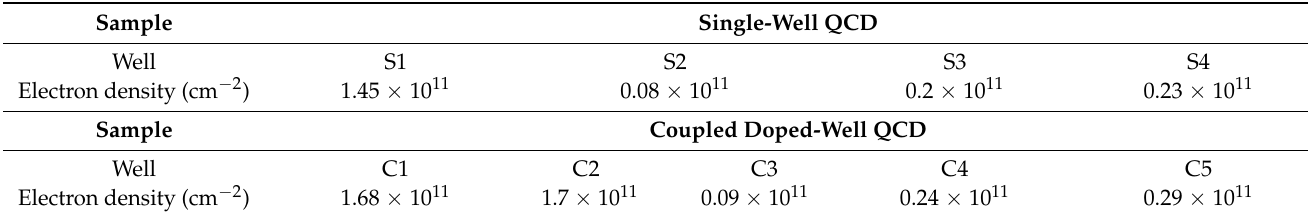
Table 2. Electron density in each well of two